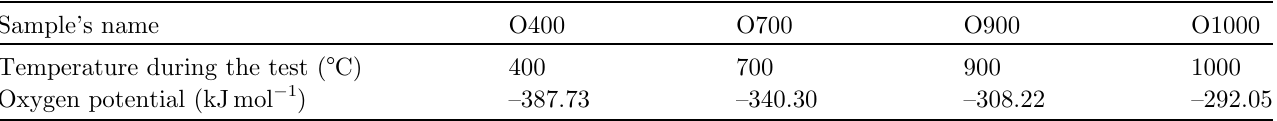
Table 2. Experimental conditions used to perform the “ oxidizing ” thermal